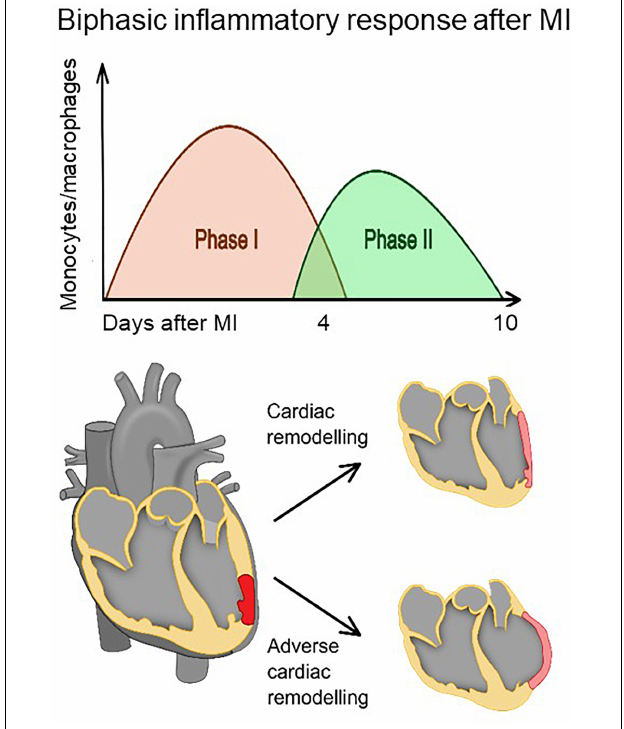
FIGURE 1 | The healing of the myocardium after infarction involves biphasic infiltration and accumulation of monocytes/macrophages to the infarct. Inflammatory monocytes/macrophages accumulate early after infarction and promote digestion and removal of the necrotic tissue, whereas reparative monocytes/macrophages accumulate later and propagate resolution of inflammation, scar formation, and repair. A proper healing process requires a precise balance between removal of debris and regulation of scar formation. Impaired resolution of inflammation (phase II) may result in prolonged inflammatory phase (phase I) and eventually adverse cardiac